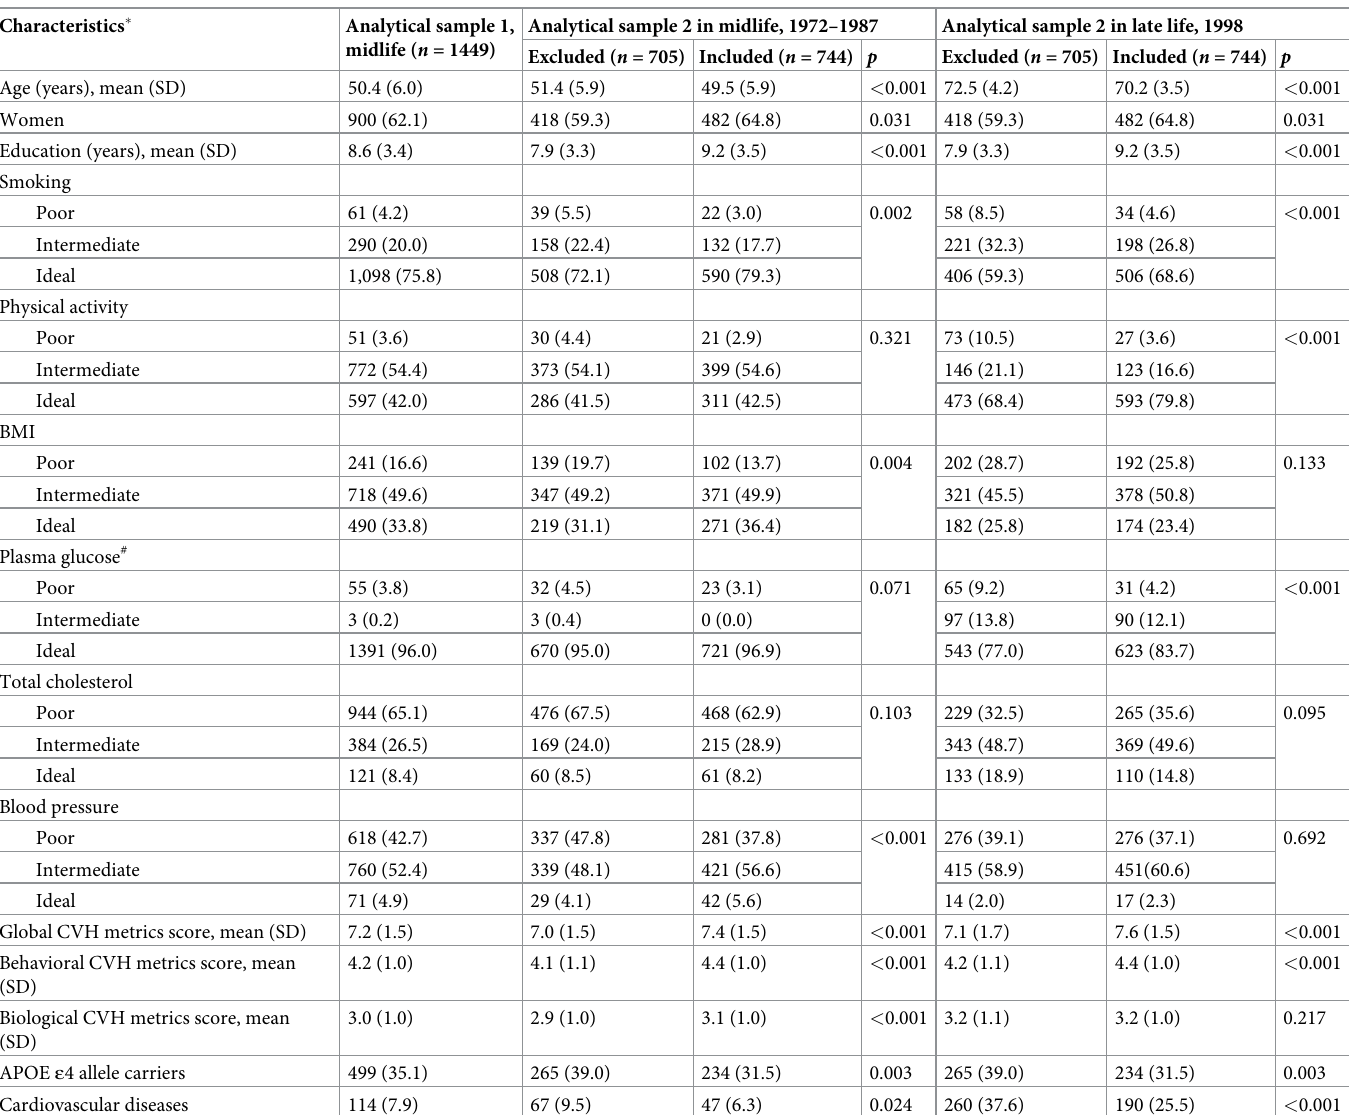
Table 2. Characteristics of study participants in midlife (1972 to 1987) and late life (1998). Characteristics